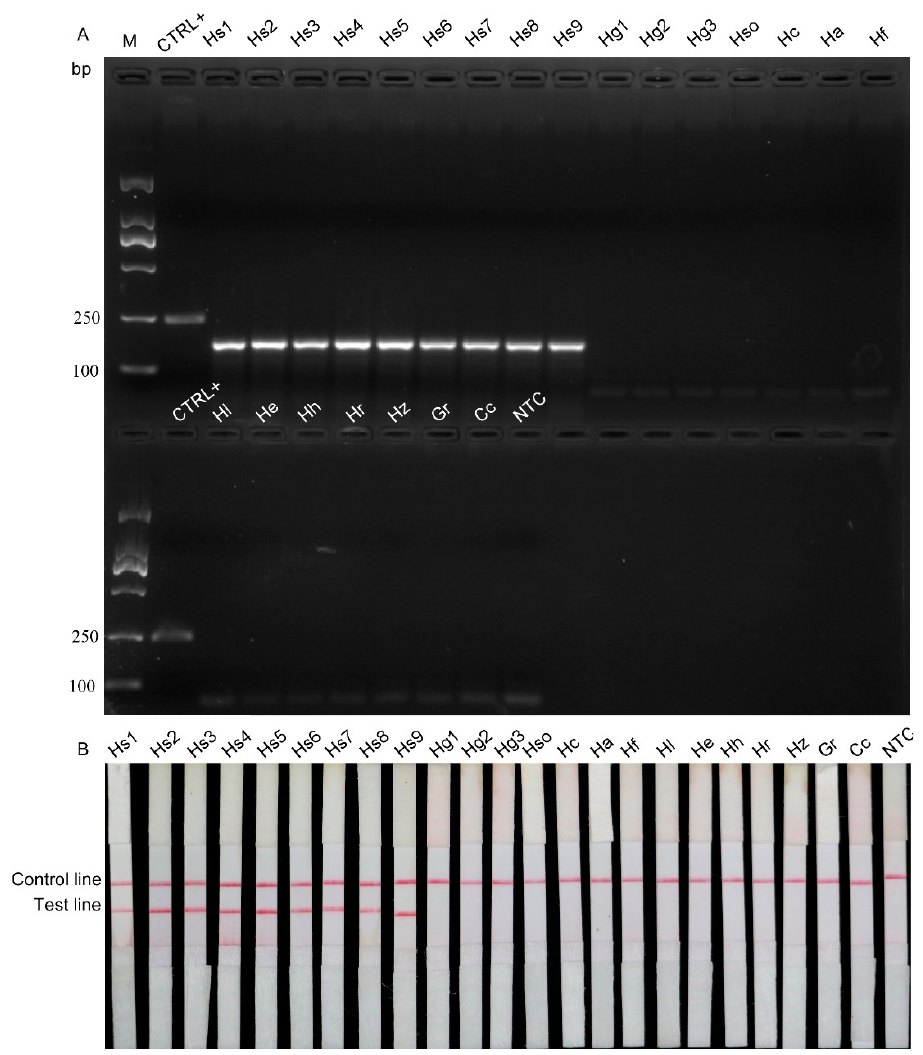
Figure 2. Verification of assay specificity for H. schachtii . ( A ) Agarose gel electrophoresis results. ( B ) LFD test strip results. CTRL+, the positive RPA control provided by the kit; M, D2000 marker; NTC, no template was added as a negative control. The presence of two lines indicates a positive result. Table 2. Cyst nematode populations